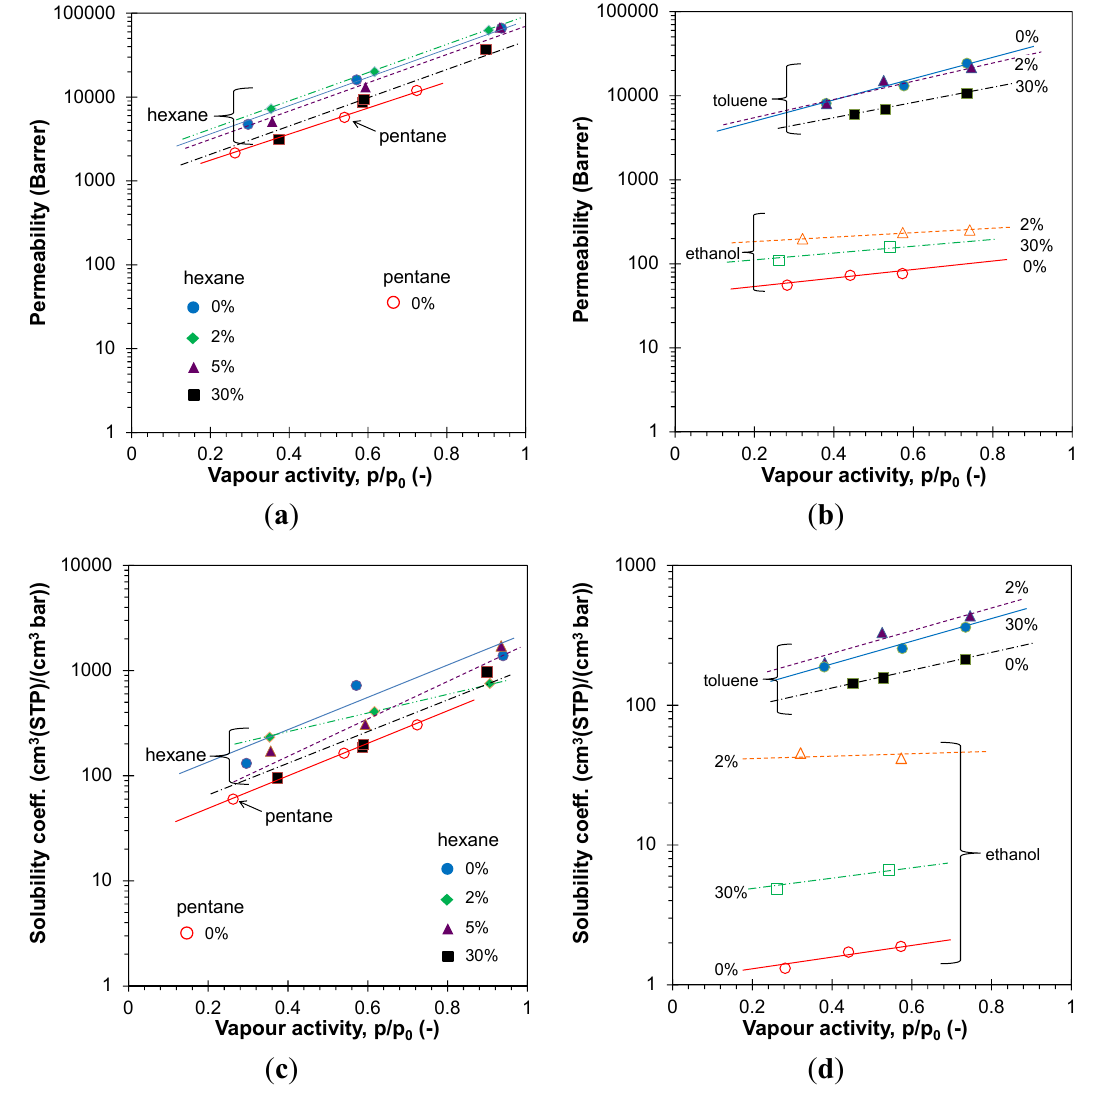
Figure 9. Alkane permeability coefficient of EOC/CNT composite films ( a ) and toluene and ethanol permeability coefficient of EOC/CF composite films ( b ) as a function of the vapor activity; ( c , d ) corresponding solubility coefficients, calculated from Equation (4). Lines are plotted as a guide to the